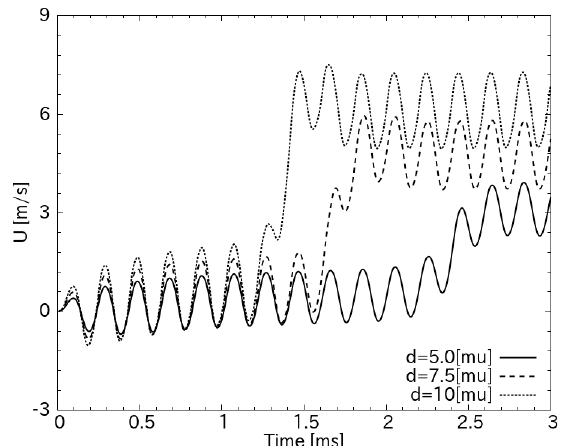
Figure 4. Transient characteristic of the flow in the working chamber with different amplitudes of the diaphragm. The flow is monitored at 2.5 mm downstream from the nozzle. The amplitudes of the diaphragm are 5 μ m, 7.5 μ m, and 10 μ m.